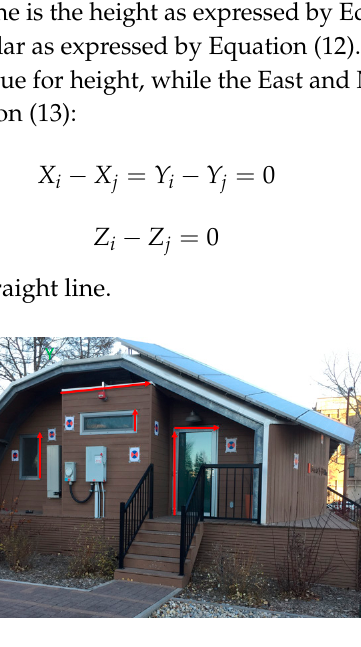
Figure 8. The Step Detection Result.